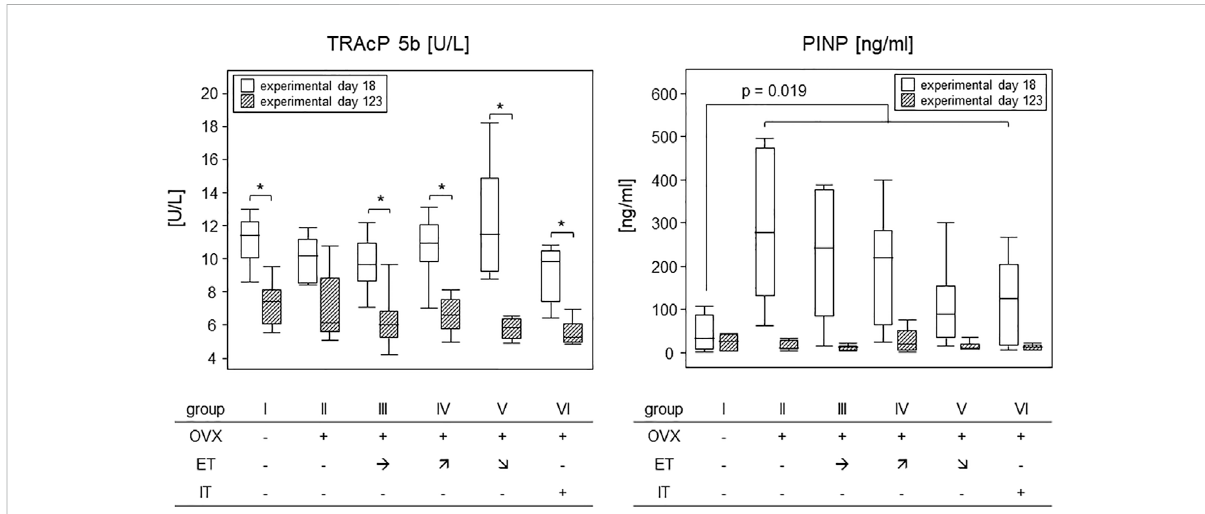
FIGURE 7 Treadmilltrainingdidnotimpactonbonemetabolism.BoxplotscompareserumTRAcP5b(leftpanel)andPINP(rightpanel)concentrations on experimental day 18 and at sacri fi ce. To describe changes in TRAcP concentrations (left panel), statistics were calculated by Wilcoxon signed-rank test, asterisks indicate statistically signi fi cant differences (* p < 0.05). For changes in PINP concentrations on experimental day 6 (right panel),